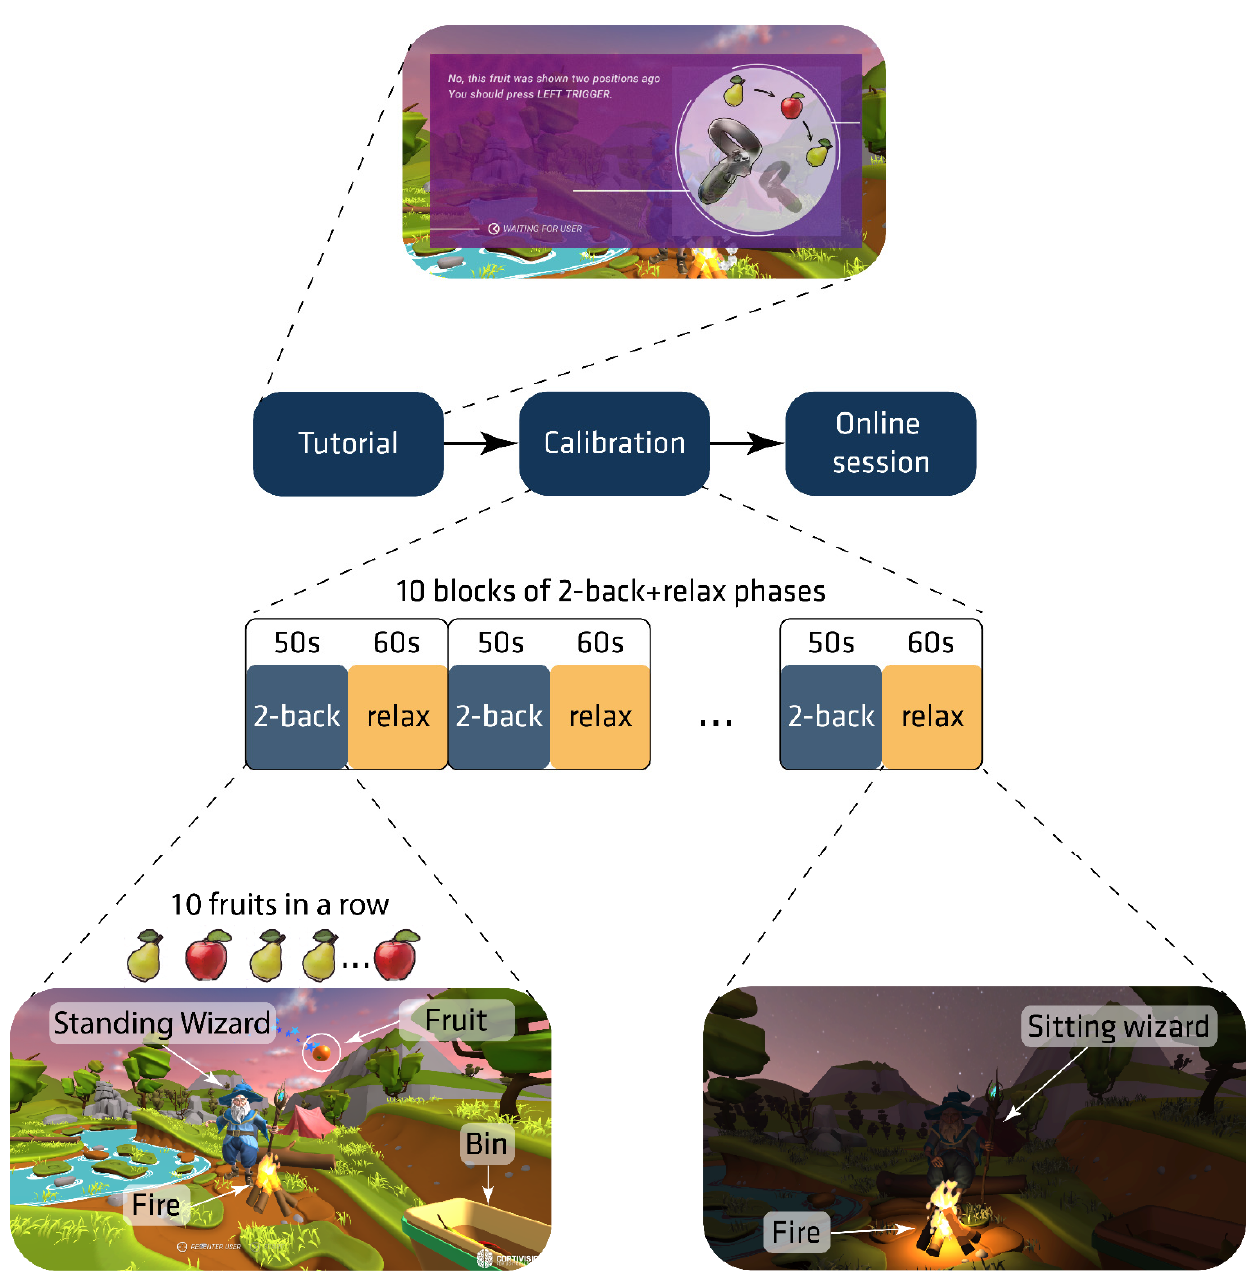
Figure 2. Experimental procedure. The upper screenshot shows a sample message with instructions on how to complete the task correctly ( top central ). The bottom screenshots present the virtual scene view during the 2-back block ( bottom left ) and relax ( bottom right ).